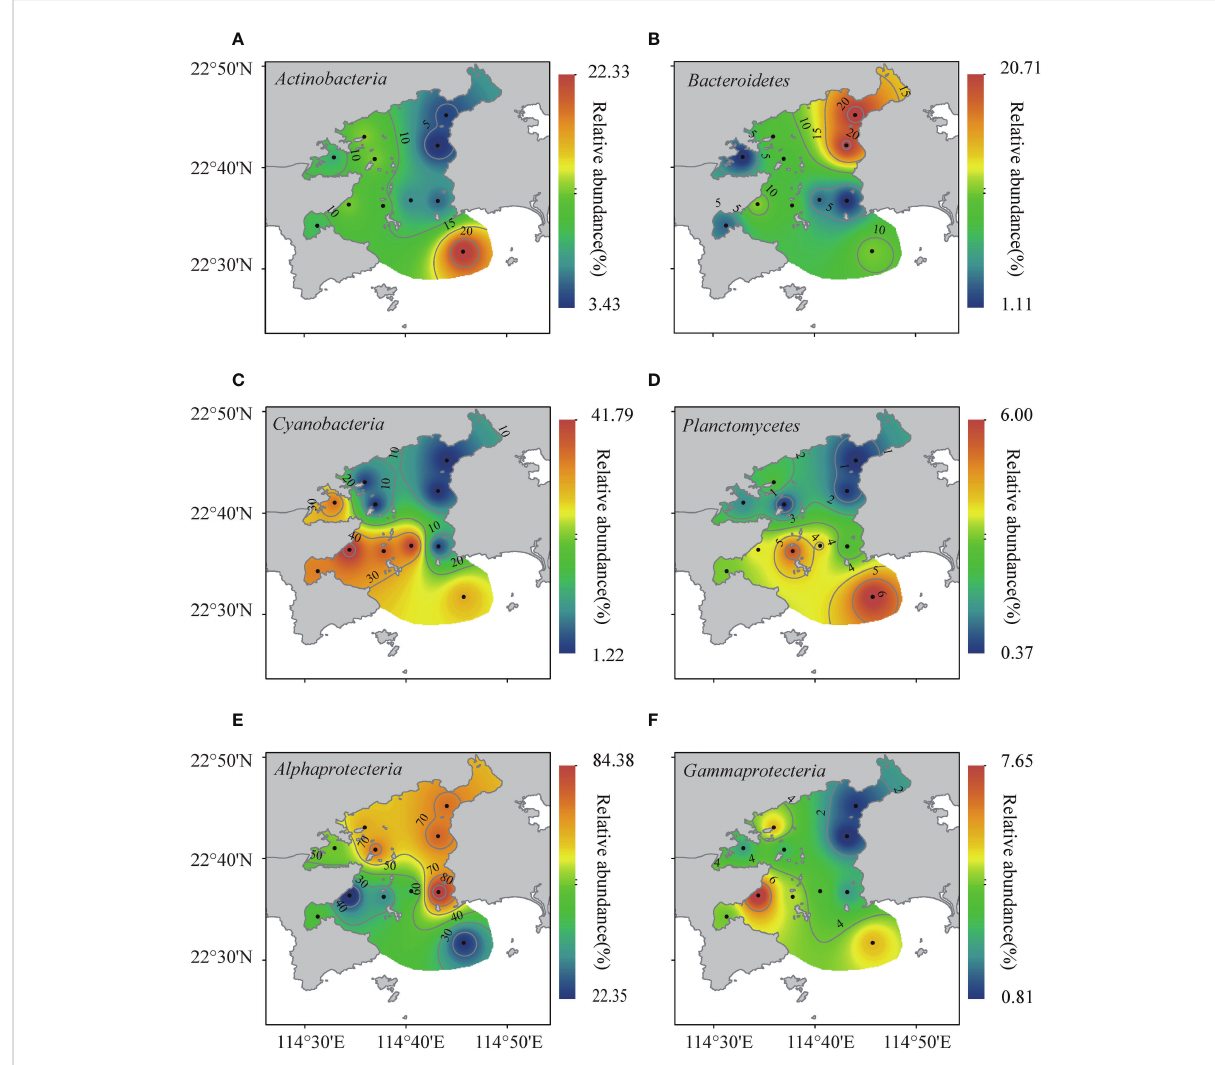
FIGURE 2 The distributions of dominant bacterial taxa in the Daya Bay, including Actinobacteria (A) , Bacteroidetes (B) , Cyanobacteria (C) , Planctomycetes (D) , Alphaproteobacteria (E) , and Gammaproteobacteria (F)